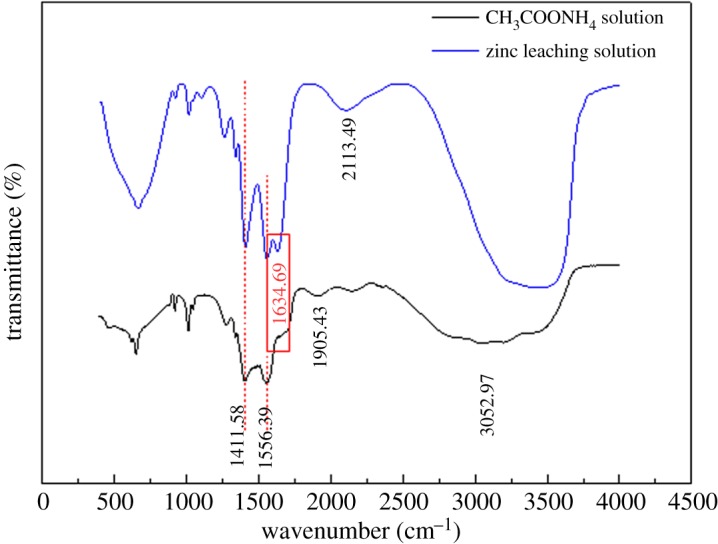
FT-IR spectra of CH3COONH4 solution and zinc leaching solution.